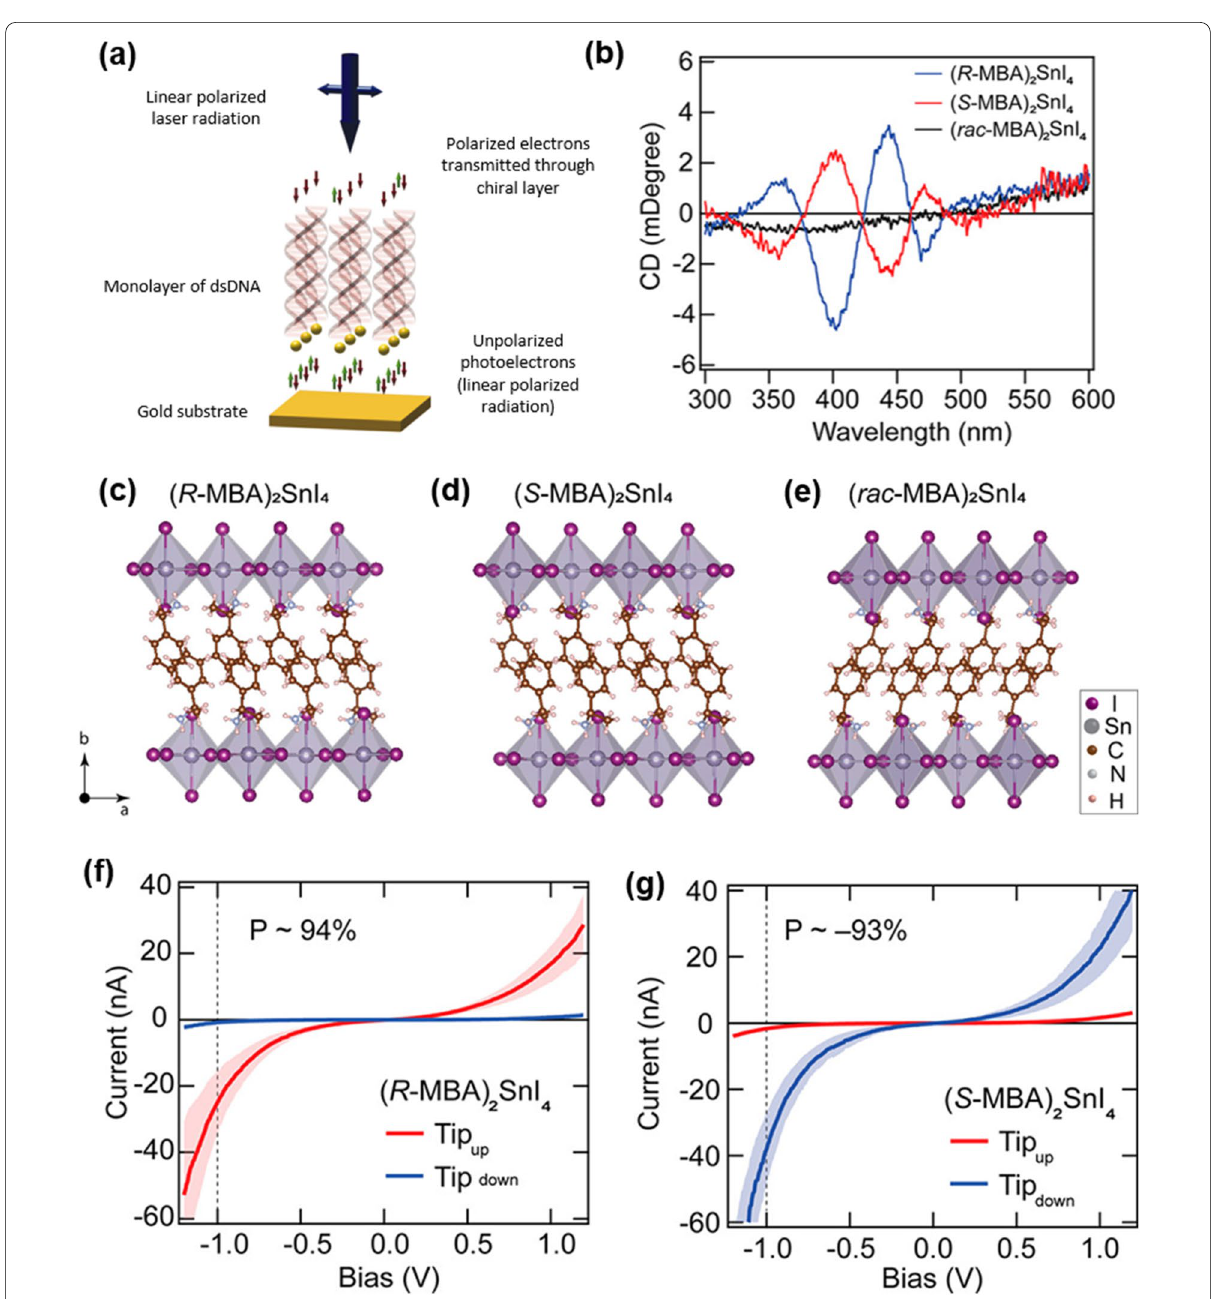
Fig. 3 a Schematics of the monolayer of dsDNA on a gold substrate as a spin filter. Reproduced with permission from [23]. Copyright 2011 AAAS. b CD signals of chiral and racemic HOIPs. Crystal structure of chiral HOIPs with c R -MBA, d S -MBA, and e rac -MBA. Room-temperature J – V curves obtained using the magnetic conductive-probe atomic force microscopy (AFM) technique of chiral 2D hybrid ( R -MBA) 2 SnI 4 f and ( S -MBA) 2 SnI 4 g thin films. Reproduced with permission from [14]. Copyright American Chemical Society,